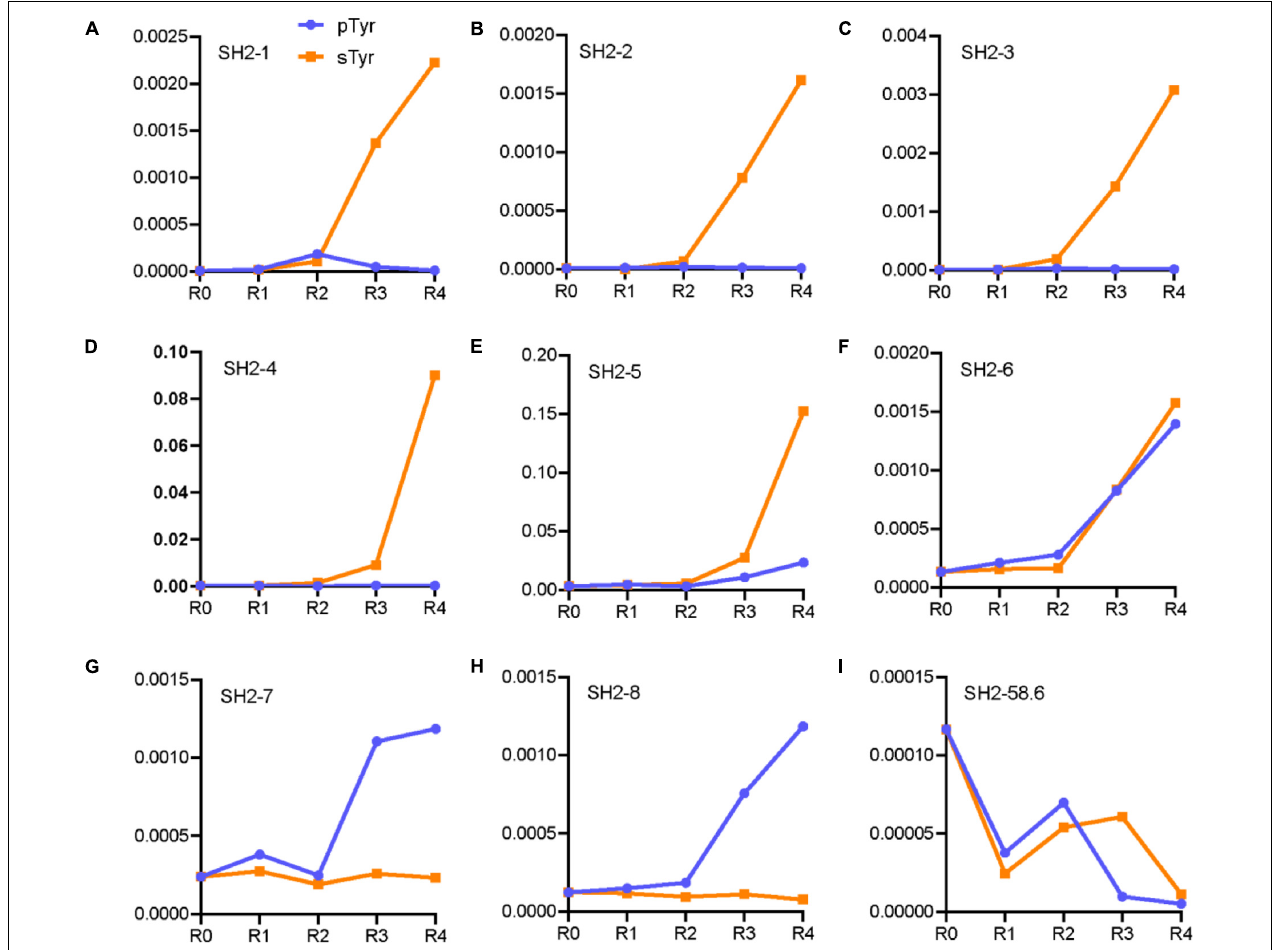
FIGURE 4 | Line chart of proportions of the variants in the rounds of selections against pTyr and sTyr peptides. These variants are SH2-1 (A) , SH2-2 (B) , SH2-3 (C) , SH2-4 (D) , SH2-5 (E) , SH2-6 (F) , SH2-7 (G) , SH2-8 (H) and SH2-58.6 (I) .